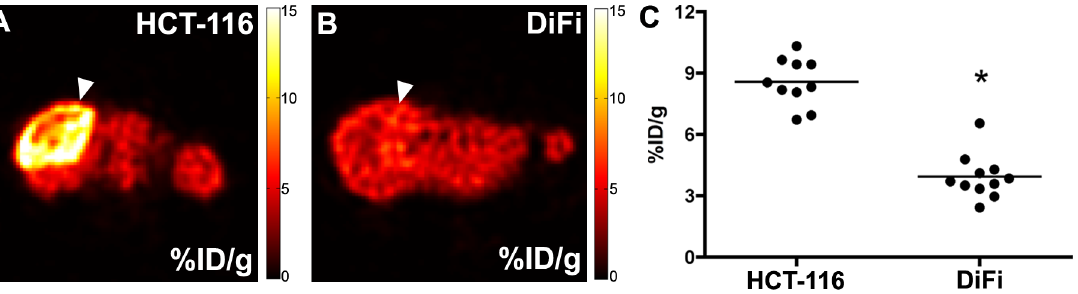
Figure 4. Static [ 18 F]-FLT PET uptake is 2-fold greater in HCT-116 xenografts than DiFi xenografts. Representative 20 minute static PET scans reflect the relative 60 minute accumulation of [ 18 F]-FLT (%ID/g) qualitatively and show increased tracer uptake in HCT-116 xenografts (A) compared to DiFi (B) xenografts (tumor localized by arrowhead). Spatially, %ID/g maps (A,B) are similar to K FLT maps derived from parametric modeling ( Fig. 3C,F ). Static PET imaging reveals approximately a 2-fold increase in [ 18 F]-FLT accumulation in HCT-116 xenografts (8.56 6 1.17 %ID/g) compared to DiFi xenografts (3.92 6 1.08 %ID/g; p , 0.0001) (C) and was similar to [ 18 F]-FLT flux (K FLT ) means derived from compartmental modeling ( Table 1